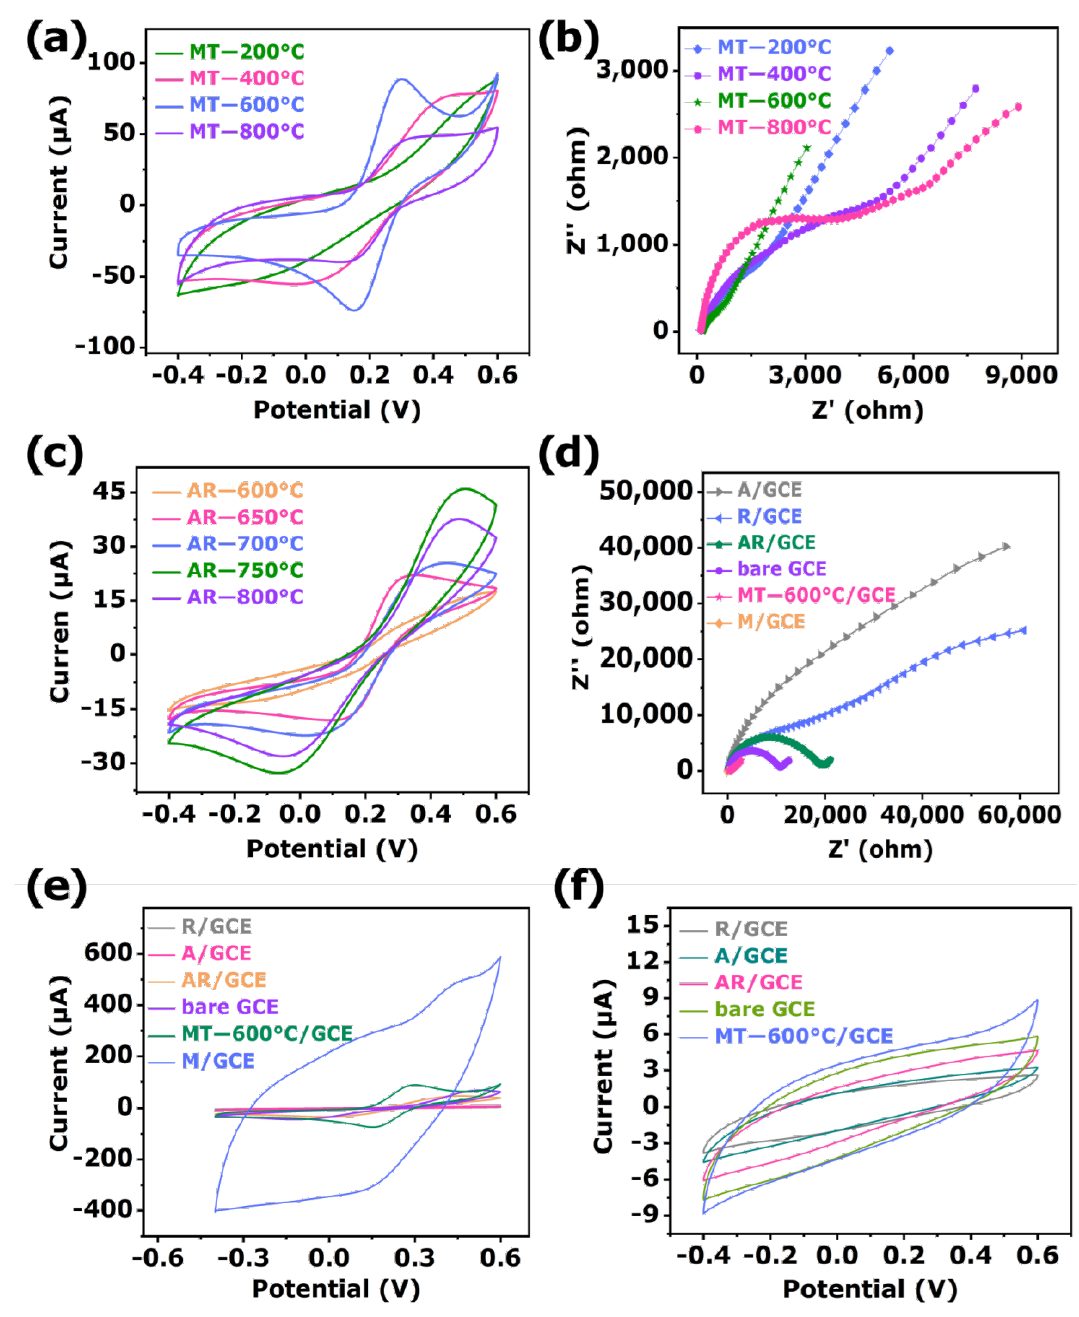
Figure 5. ( a ) CV and ( b ) EIS of the MT-200, MT-400, MT-600, and MT-800 ◦ C in 5 mM [Fe(CN) 6 ] 3 − / 4 − solution containing 0.1 M KCl. ( c ) CV of the AR-600, AR-650, AR-700, AR-750, and AR-800 ◦ C in 5 mM [Fe(CN) 6 ] 3 − / 4 − solution containing 0.1 M KCl. ( d ) EIS and ( e ) CV of the bare GCE, A/GCE, R/GCE, AR/GCE, M/GCE, and MT-600 ◦ C/GCE in 5 mM [Fe(CN) 6 ] 3 − / 4 − solution containing 0.1 M KCl. ( f ) CV of the bare GCE, A/GCE, R/GCE, AR/GCE, and MT-600 ◦ C/GCE in artificial sweat (pH = 7.0) containing 1 mg/mL β -Casein.